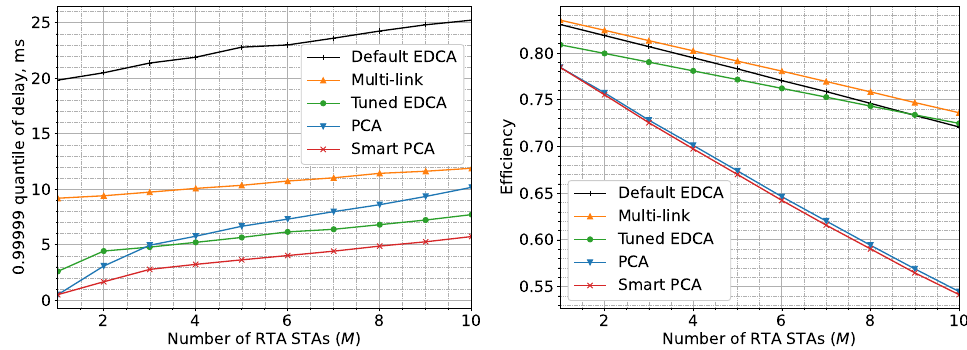
Figure 4. Delay quantile and efficiency vs. the RTA STAs number M in case of T period = 50ms, σ = 10µs, TXOP Limit =